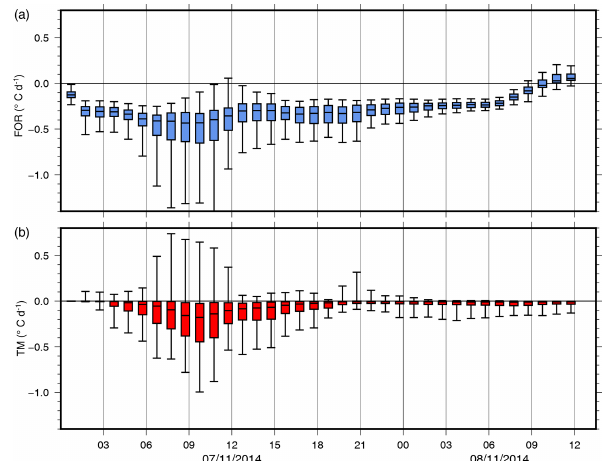
Figure 8. Time series of the median values of the surface forcing (FOR) (a) and turbulent mixing (TM) (b) tendency terms in the evolution of the temperature in the OML and in the SFA. The boxes correspond to the 25% and 75% quantiles and the whiskers to the 5% and 95% quantiles.